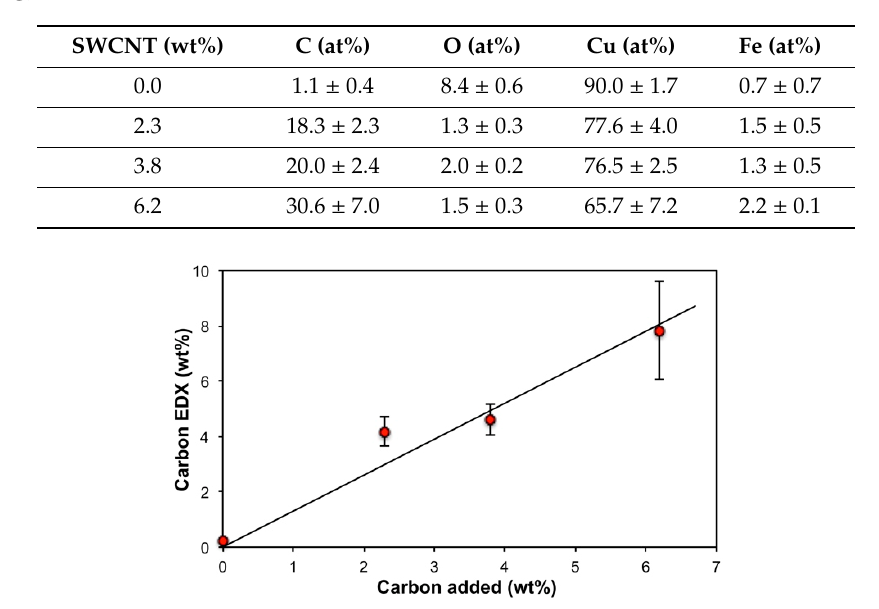
Figure 2. Plot of carbon (wt%) determined by EDX analysis versus carbon (wt%) added in the form of SWCNTs to the electrolysis (R 2 = 0.95). EDX shown as an average of 5 independent measurements per sample.